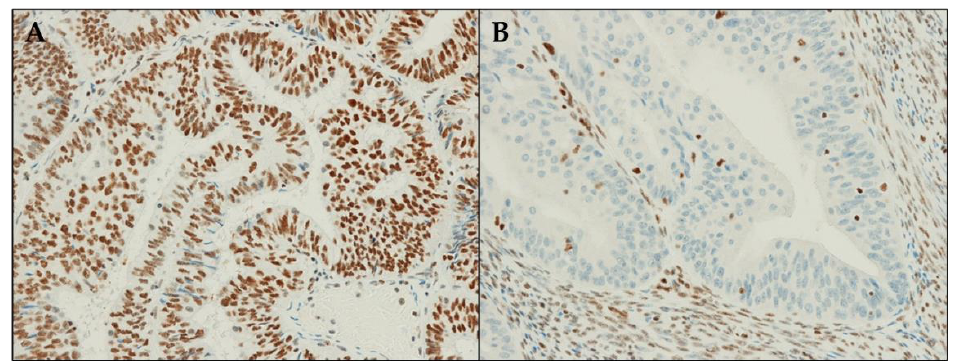
Figure 1. Immunohistochemical staining for ARID1A. ( A ) Preserved expression; ( B ) Loss of expres- sion. Magnification: 200×.